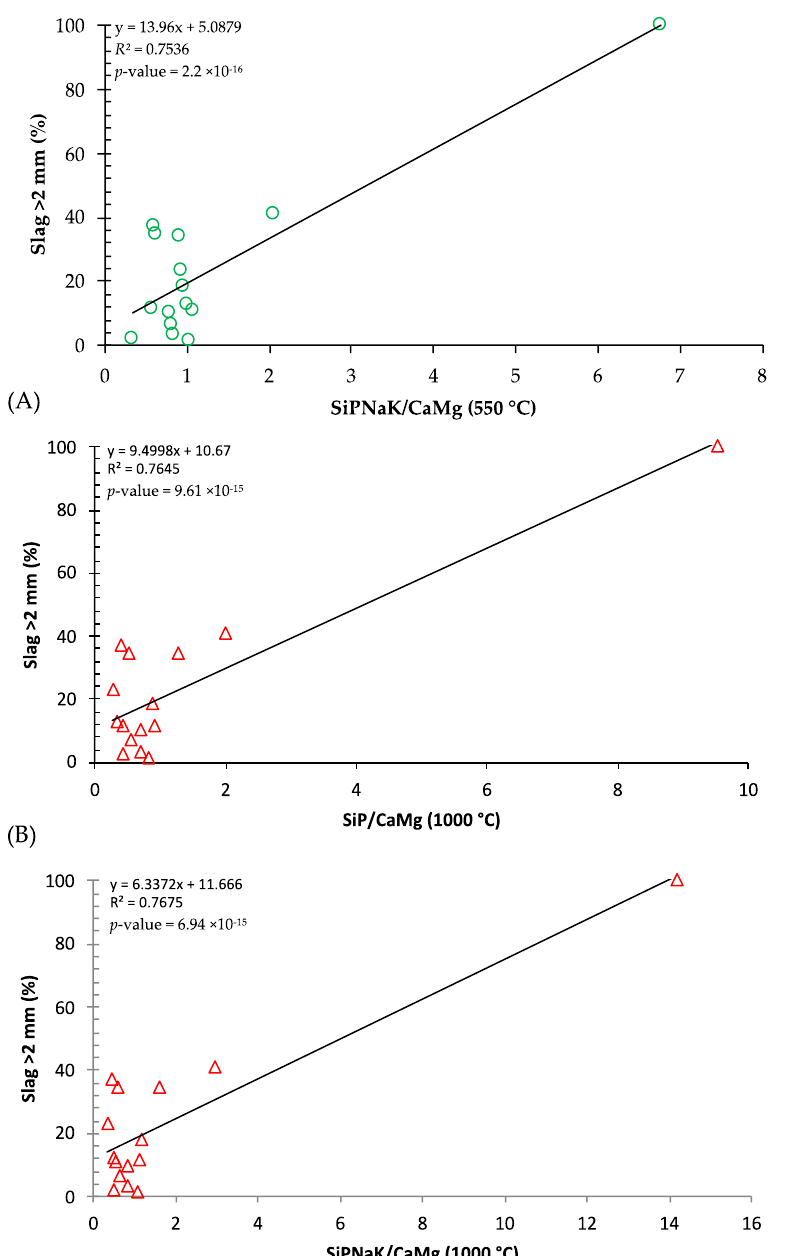
Figure 8. Correlations of the accumulated percentage of slag >2.00 mm measured in the BioSlag test. Graphs shown the equation and R 2 values: ( A ) Percentage of slags and SiP/CaMg index at 550 °C; ( B , C ) Percentage of slags and SiPNaK/CaMg index at 550 and 1000 °C, respectively.